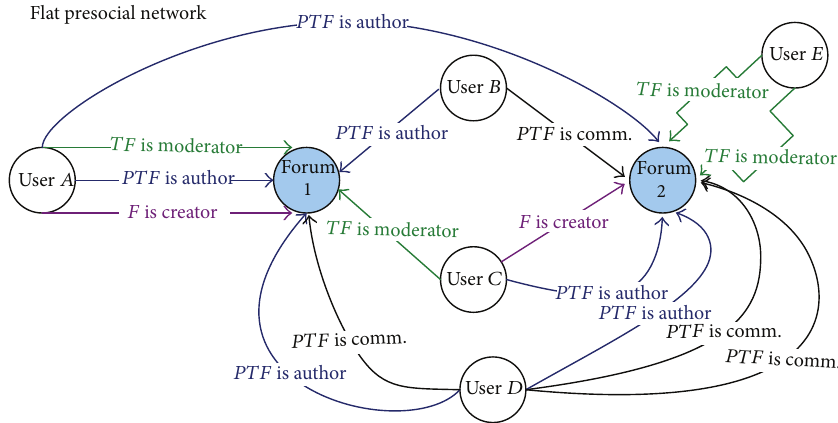
Figure 12: Flat presocial network (FPSN): the result of flattening process applied to HPSN from Figure